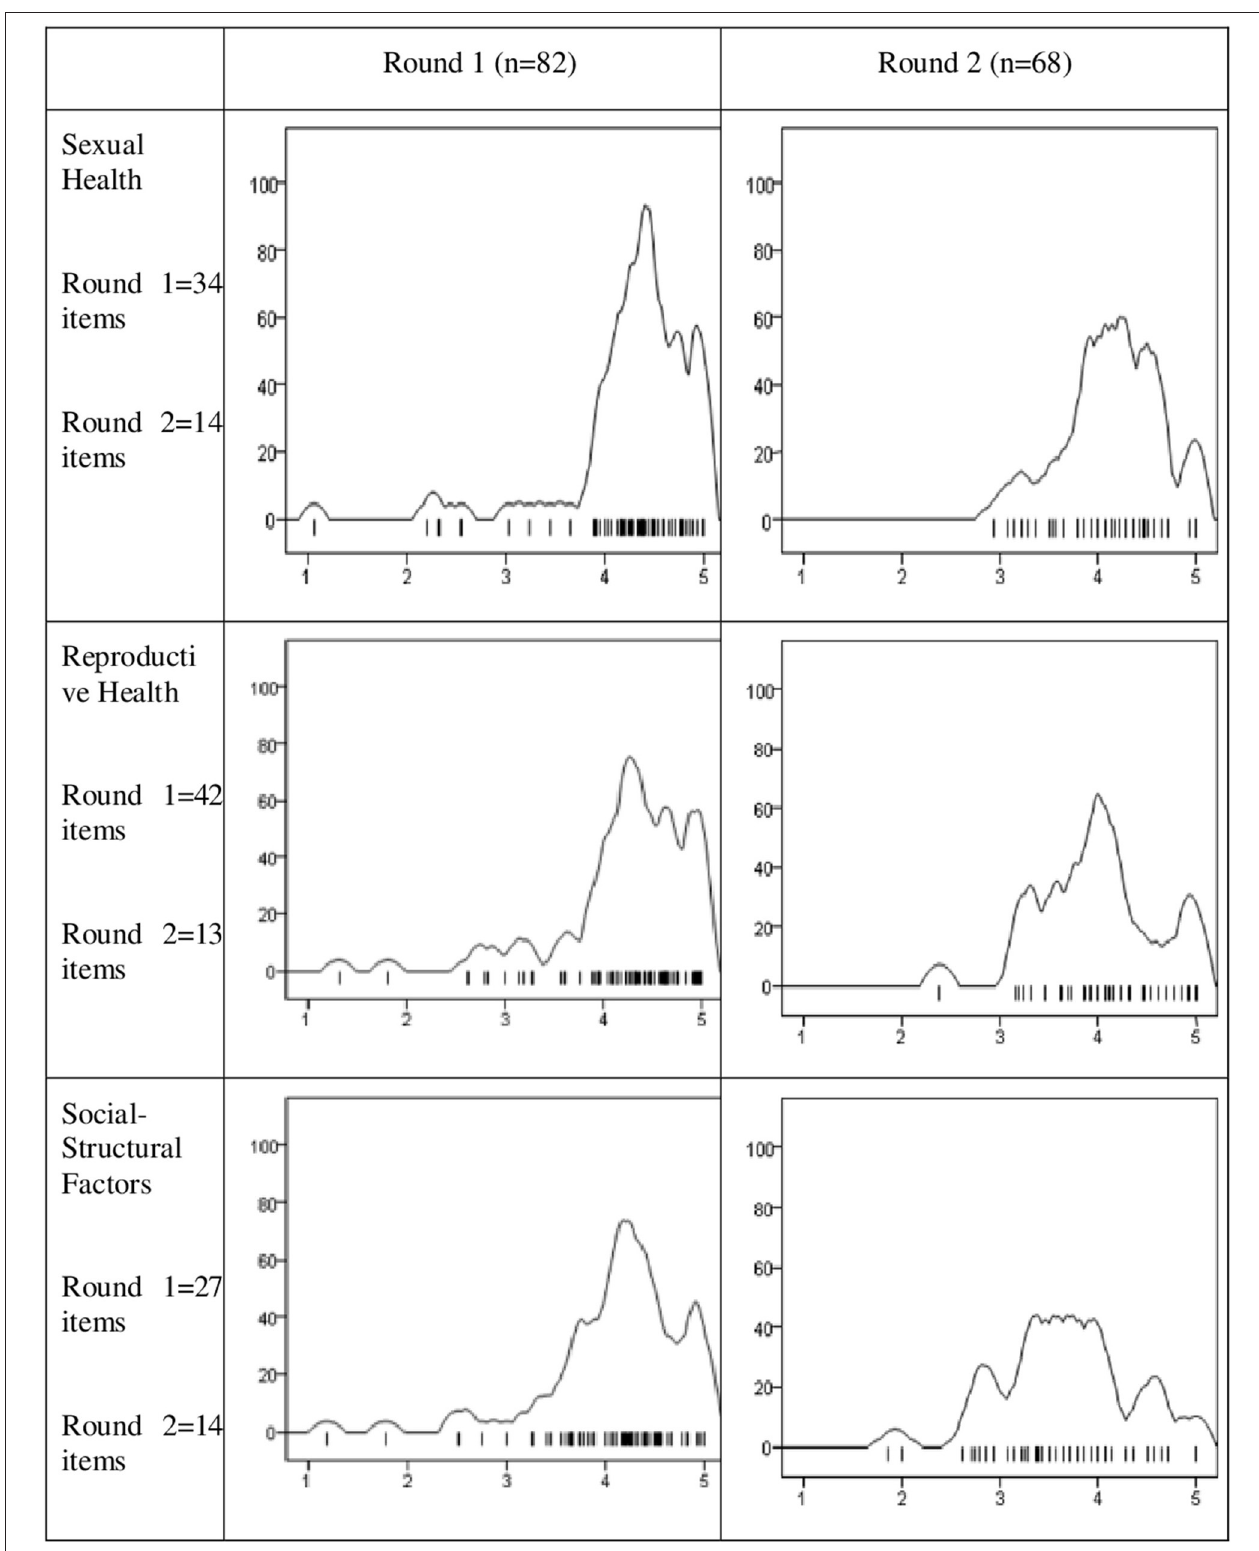
FIGURE 7 | Kernel Density Curves for the panelists mean responses for each round and dimension.